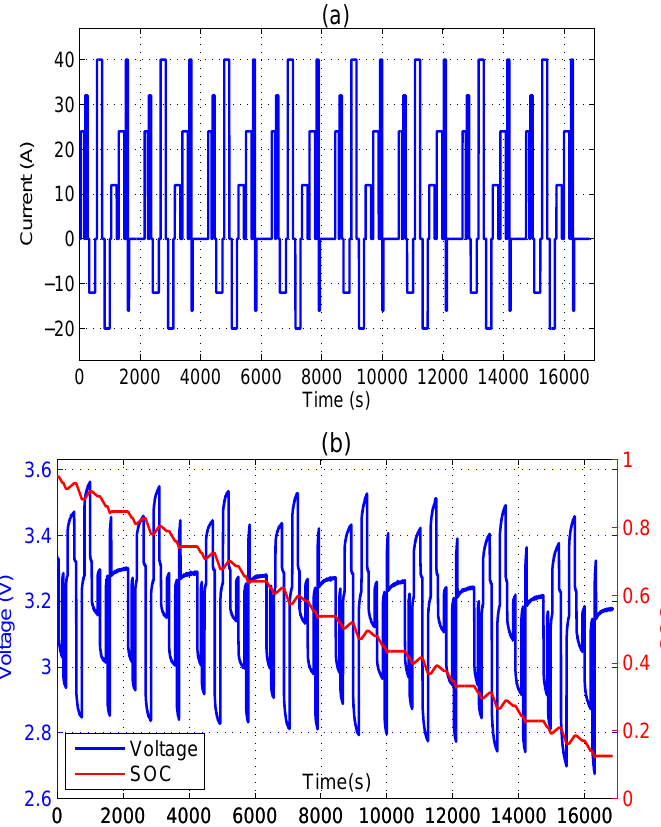
Figure 4. ( a ) Dataset of hybrid pulse test on WB-LYP40AHA: current; ( b ) Dataset of hybrid pulse test on WB-LYP40AHA: voltage and SOC.